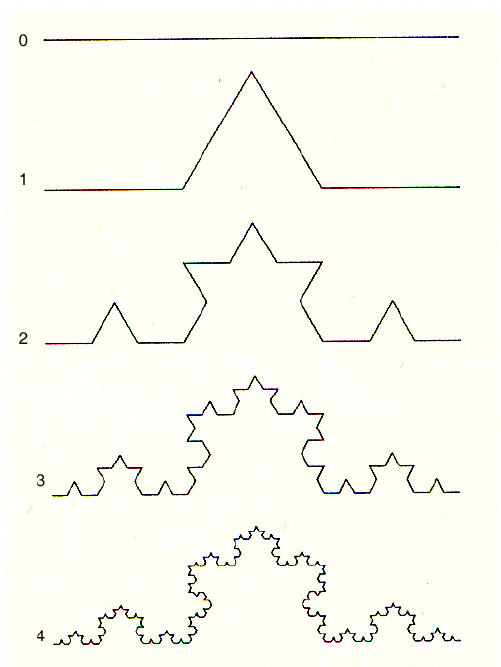
Figure 1. First five stages of the Koch curve